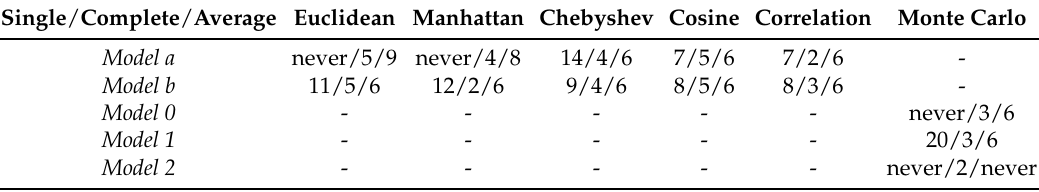
Table 2. The minimum number of clusters for which a second group of at least three users is identified. Single / Complete / Average Euclidean Manhattan Chebyshev Cosine Correlation